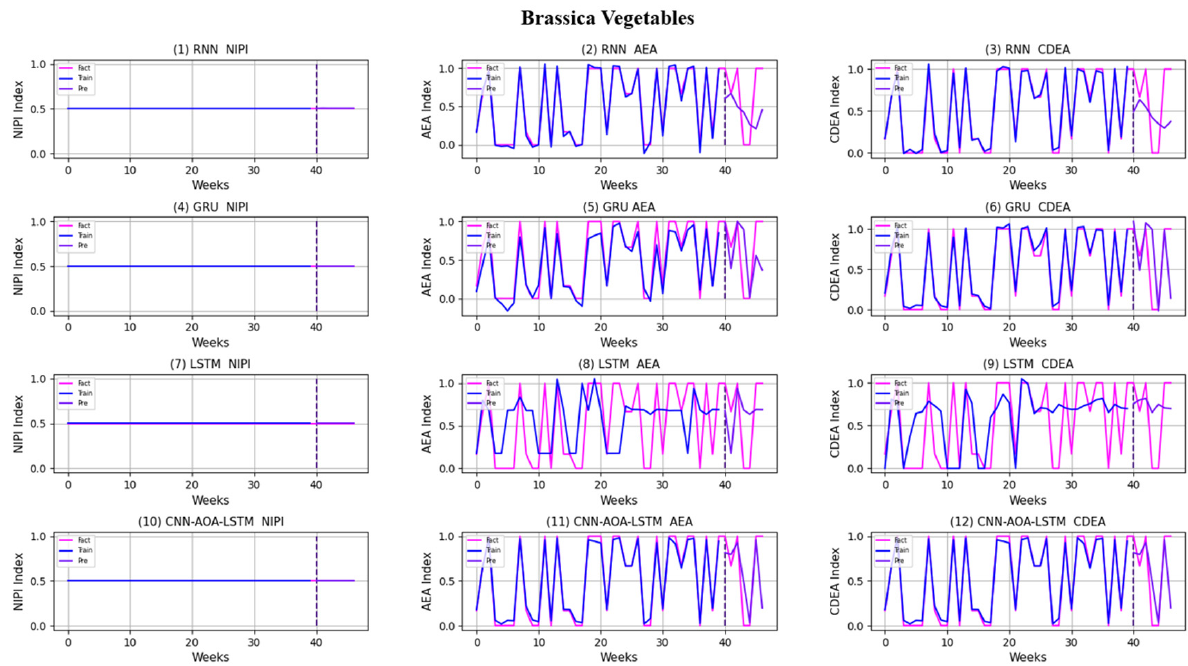
Figure 13. Prediction results of indexes of root and yam vegetables (except potatoes).